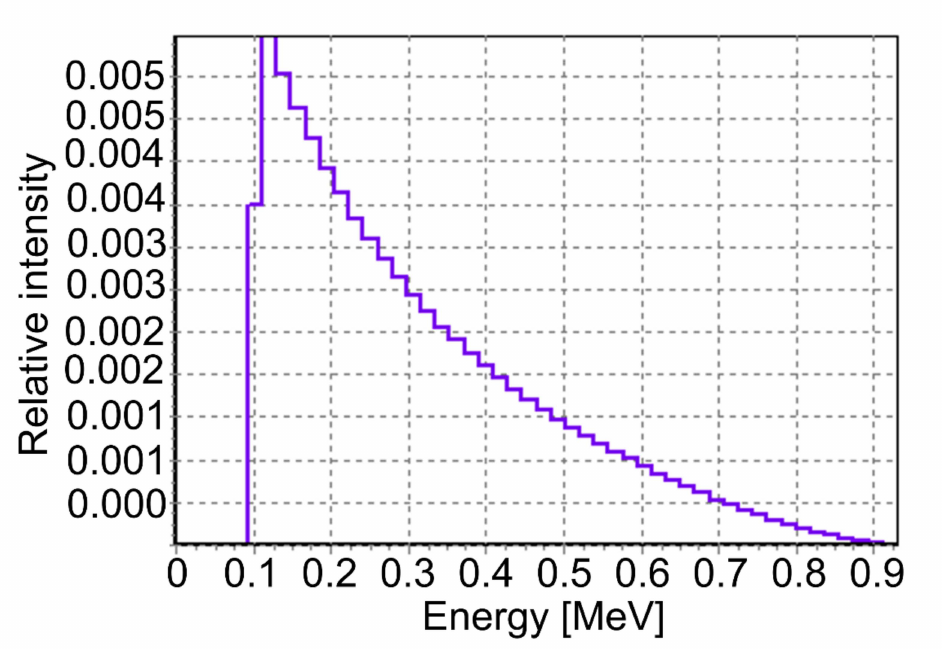
Figure 4. Simulated energy spectrum of electromagnetic radiation generated by the beam of electrons of energy 930